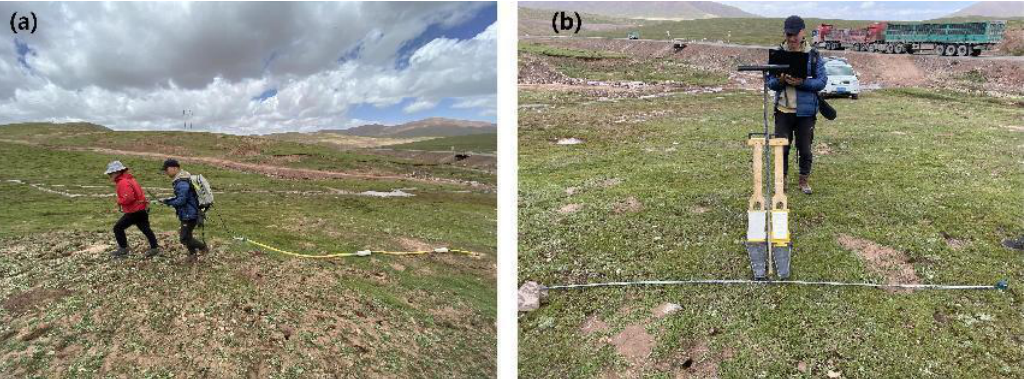
Figure 2. Ground ‐ penetrating radar investigation modes with two different antennas: ( a ) 100 ‐ MHz Figure 2. Ground-penetrating radar investigation modes with two different antennas: ( a ) 100-MHz shielded rugged terrain antenna, and ( b ) 100 ‐ MHz unshielded antenna. shielded rugged terrain antenna, and ( b ) 100-MHz unshielded antenna.